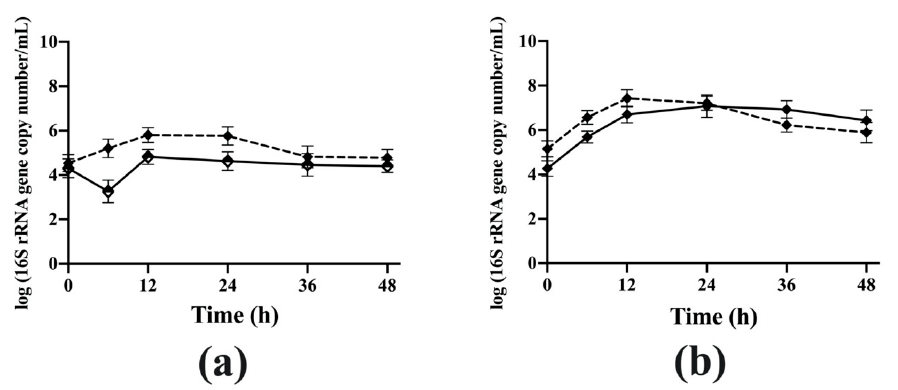
Figure 4. The quantification by ddPCR ( a ): 16S rRNA gene copy number of live B. longum subsp. longum NCC 2705; ( b ): 16S rRNA gene copy number of live Bac. caccae ATCC 43185) of monoculture B. longum subsp. longum NCC 2705 (half solid diamond) and Bac. caccae ATCC 43185 (diamond), and coculture of both strains (dashed line) in YC-AG medium. All experiments were done three independent